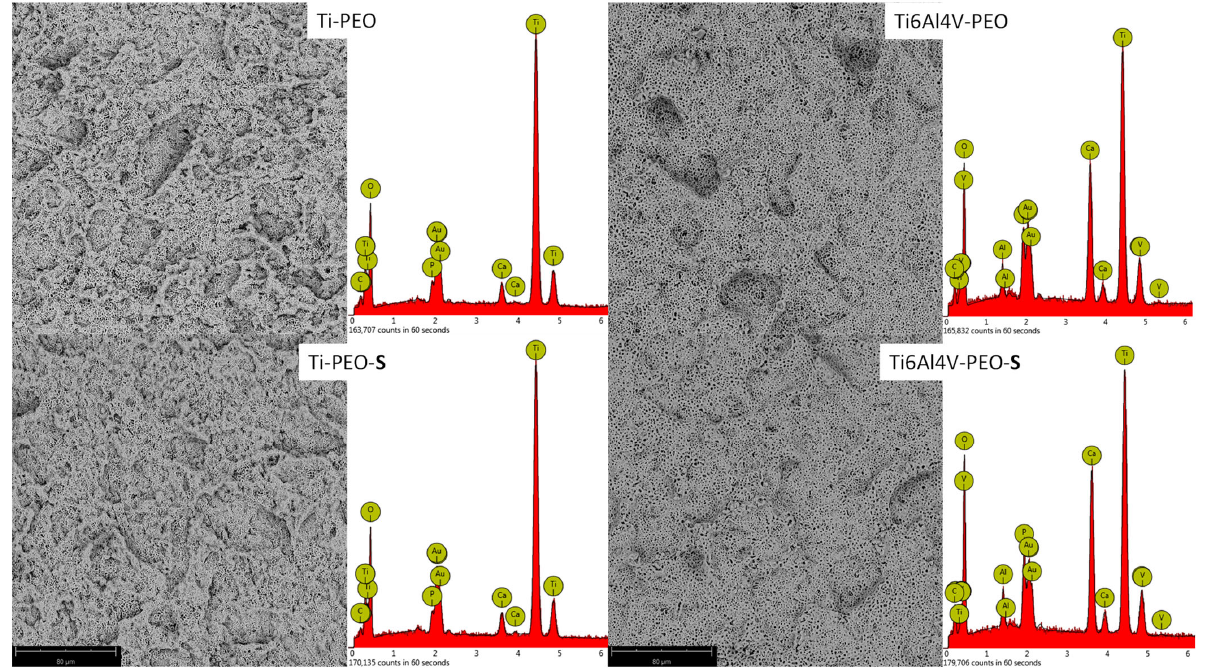
Figure 2. The SEM images of etched Ti and Ti6Al4V samples after the PEO process (Ti-PEO, Ti6Al4V-PEO) and after the PEO process with oxygen plasma treatment (Ti-PEO-S, Ti6Al4V-PEO-S). Table 1. The semi-quantitative EDX analysis of treated samples, composition in percent (%).